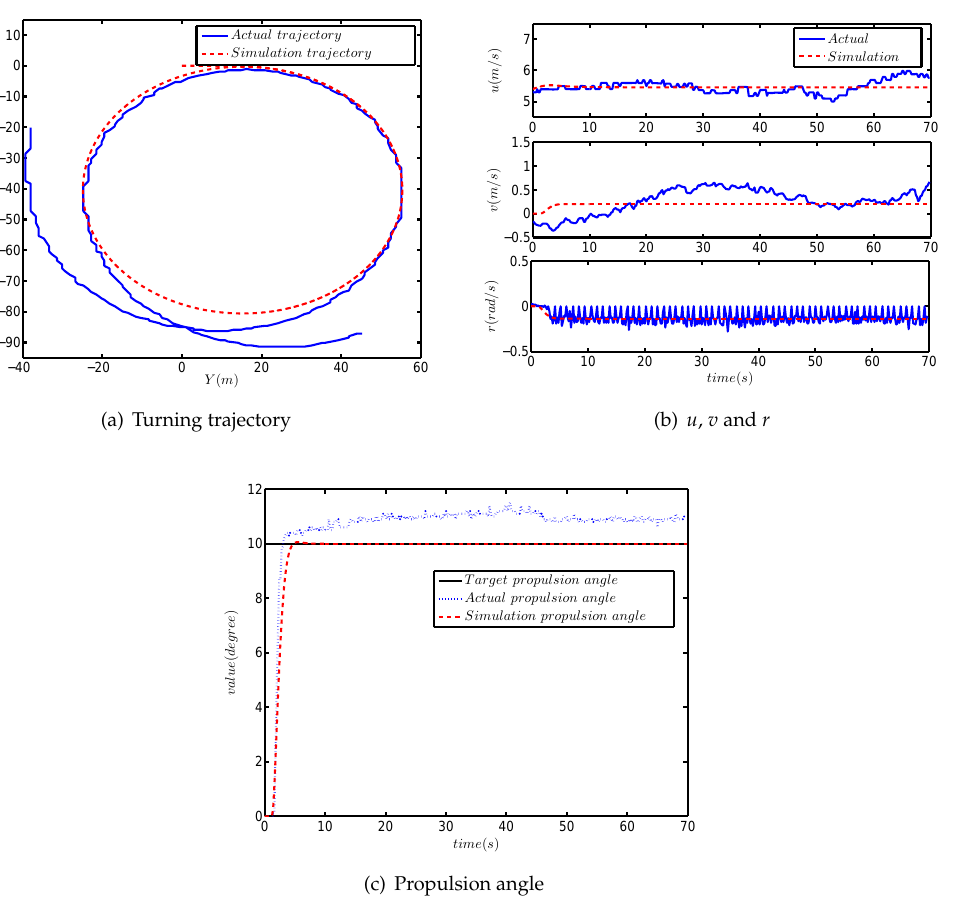
Figure 8. The comparison results of the turning